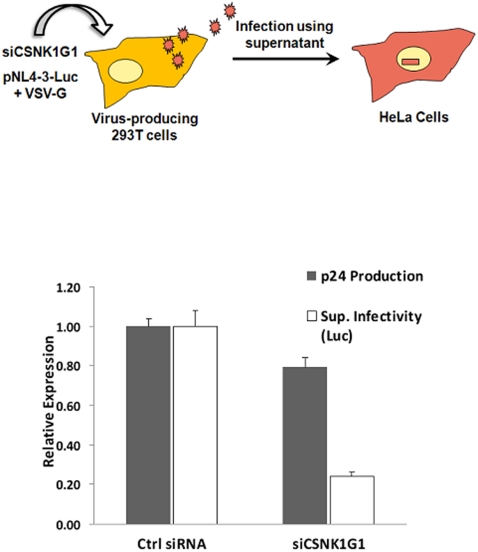
CSNK1G1 depletions.As illustrated, 293T cells were transfected with either control siRNAs or siRNAs against CSNK1G1. One day later, cells were co-transfected with the pNL4-3-Luc and pVSV-G plasmids for virus production. Supernatants were collected 48 hours later and p24 levels were measured by an ELISA assay. Infectivity of supernatants containing reporter the NL-4-3-Luc reporter viruses were measured by infecting HeLa cells with equal volume of supernatants, and Luciferase expression was measured 48 hours post-infection. Luciferase expression was normalized to the amount of p24 in the input supernatants.